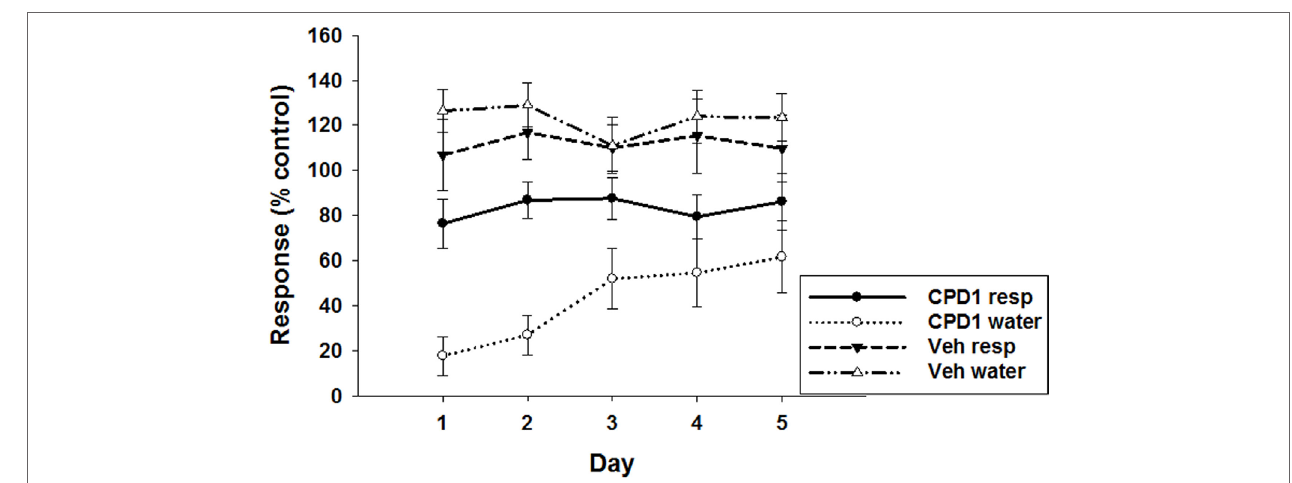
FigUre 10 | effects of cPD1 on schedule-induced polydipsia over five consecutive days of dosing . CPD 1 (10 mg/kg) significantly decreased excessive water consumption ( F 1,40 = 128.5, p < 0.0001) and to a lesser extent response output over 5 days ( F 1,40 = 11.7, p < 0.05). The factor of day of dosing did not significantly impact effects of CPD1 (responses: F 4,40 = 0.11, p = 0.98; water: F 4,40 = 0.49, p = 0.74) nor was there any significant day × treatment interaction (responses: F 4,40 = 0.06, p = 0.99; water: F 4,40 = 1.37, p = 0.26). There was not a significant attenuation of the effect of CPD 1 over 5 days ( F 4,20 = 1.46, p = 0.25). Data are means ± SEM of 5